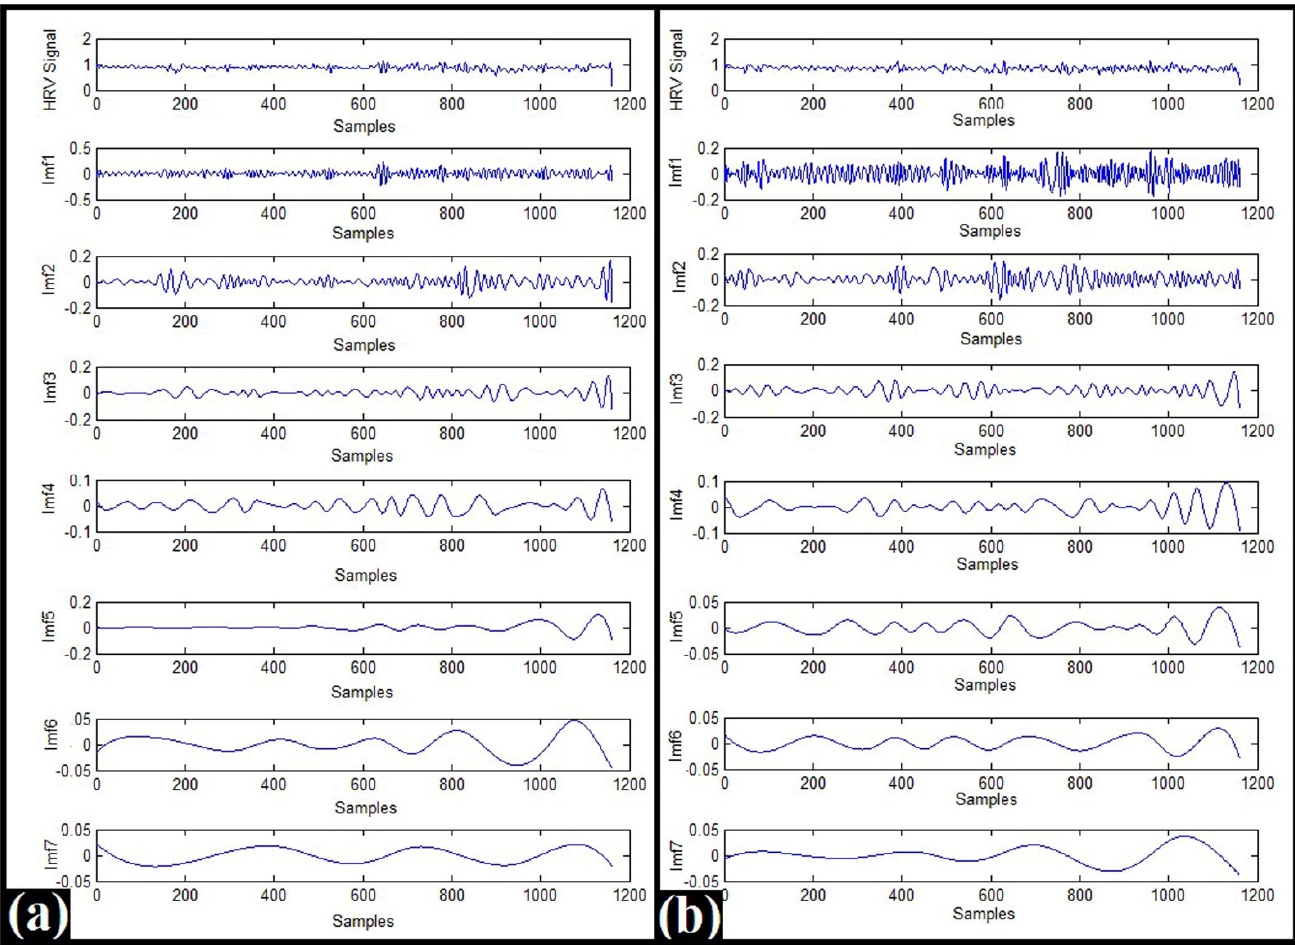
Figure 1 . Typical IMFs of 5 min HRV signals: ( a ) Category-C and ( b ) Category-B. Figure 1. Typical IMFs of 5 min HRV signals: ( a ) Category-C and ( b ) The extraction of 11 entropy-based parameters (described in Section 4.3) was carried out from each of the IMFs. The extracted parameters were named XY, where X represents the IMF name and Y indicates the base name of the parameter. Out of the 77 parameters extracted from 7 IMFs, 49 parameters were found to have non-normal distribution, and